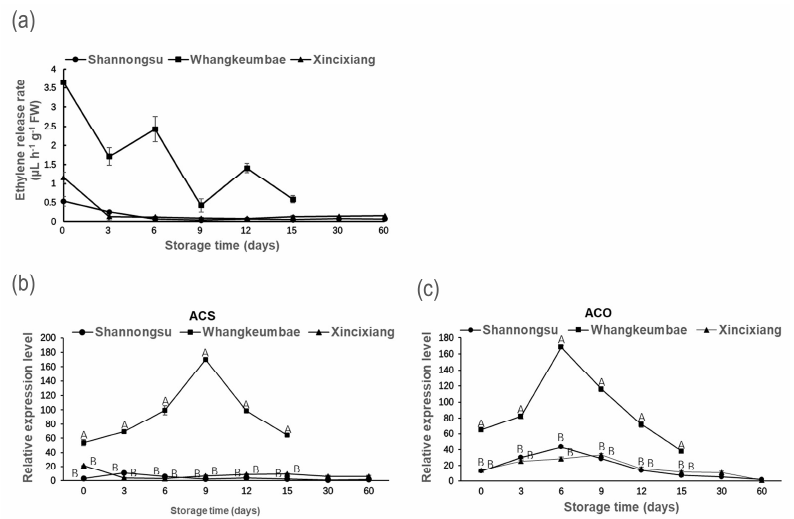
Figure 2. (a) Ethylene release rate in three pear cultivars; (b)Gene expression of ACS relative expression levels in three pear cultivars; (c) Gene expression of ACO relative expression levels in three pear cultivars. Values shown represent means ± SD (n = 3). Different letters indicate significant differences between treatments ( p ≤ 0.01).